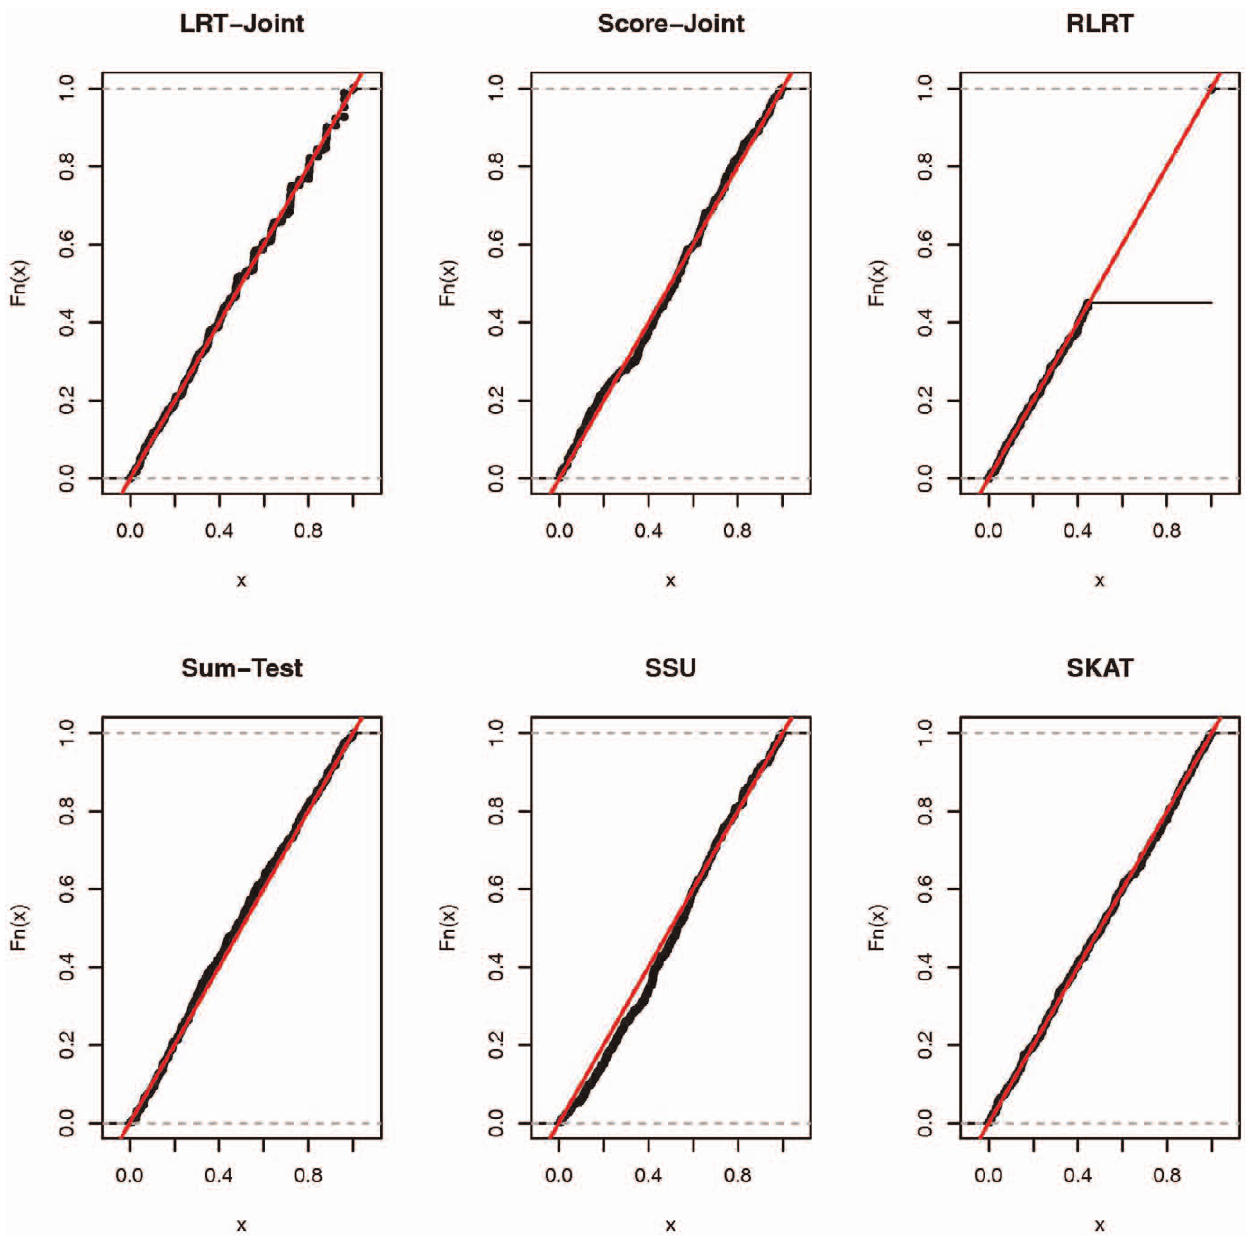
Figure 2. Empirical cumulative distribution function ( ECDF ) of the p -values under the null for binary trait.